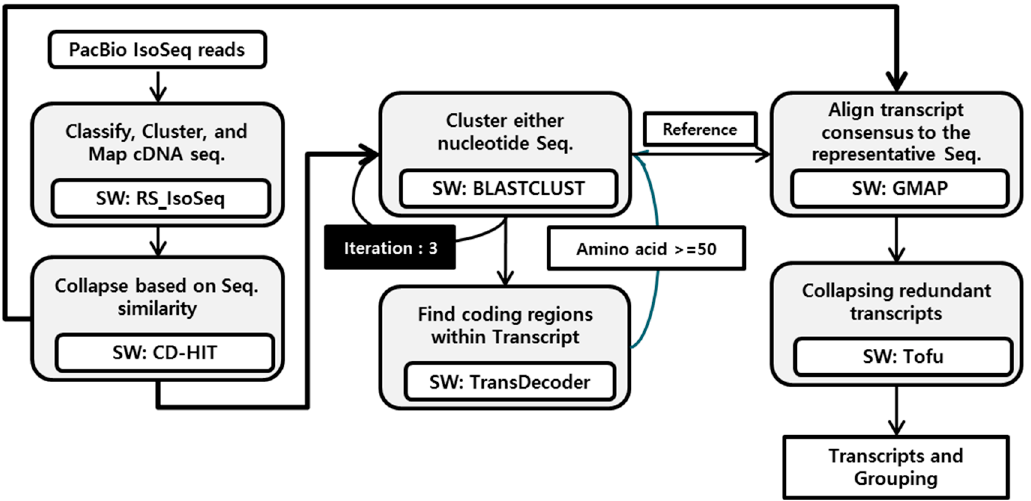
Figure 1. Schematic diagram of pipeline to isoforms of full ‐ length complementary DNA (cDNA) sequence (PIS system).